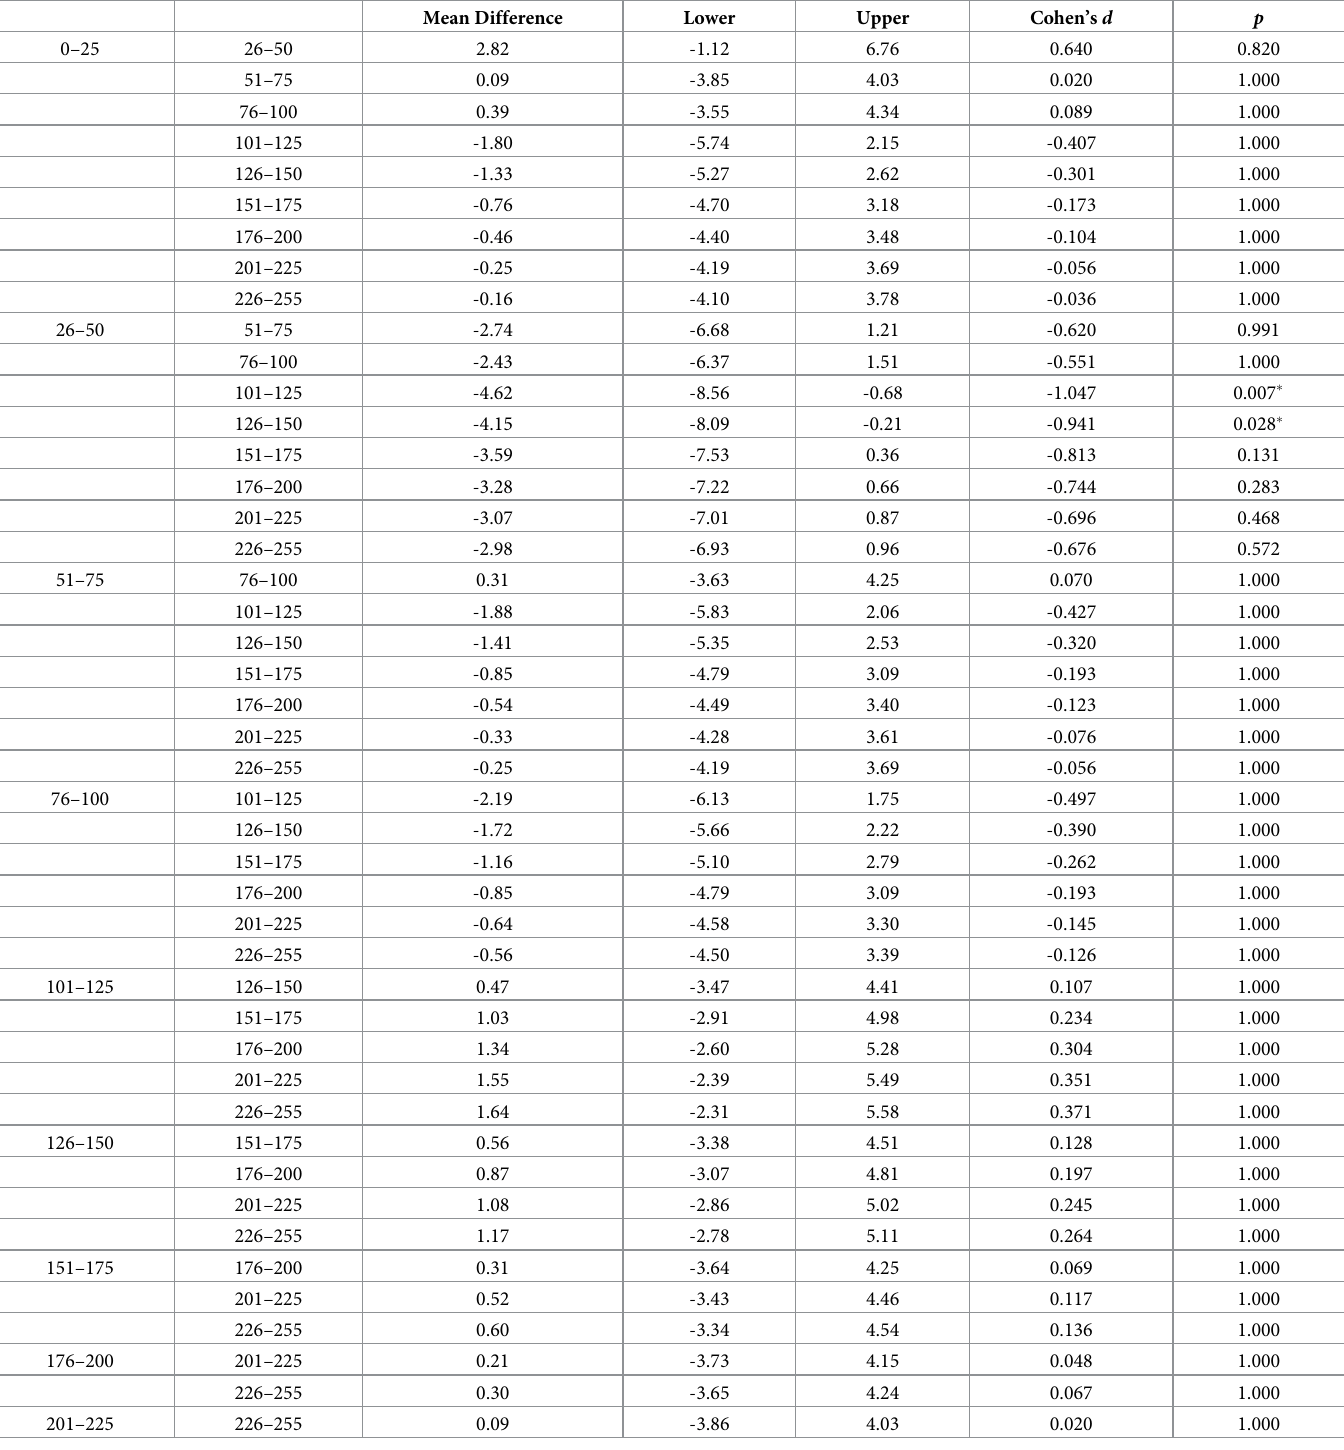
Table 3. 25 A.U. band pairwise comparisons following one-way